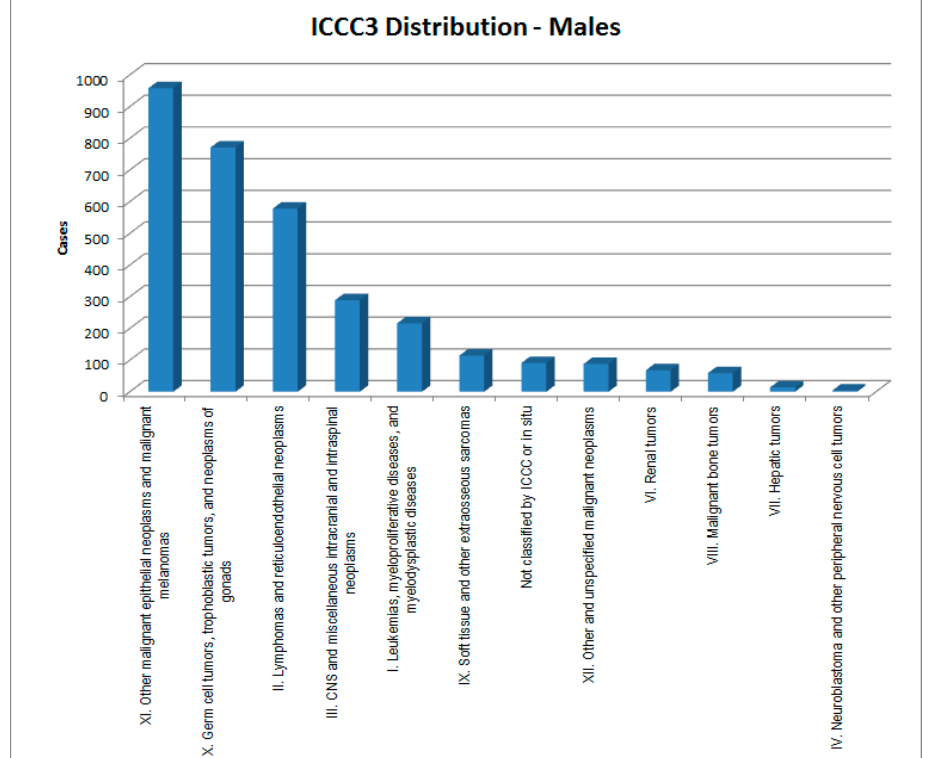
Figure 2. ICCC3 (standard) distribution of cases—males.